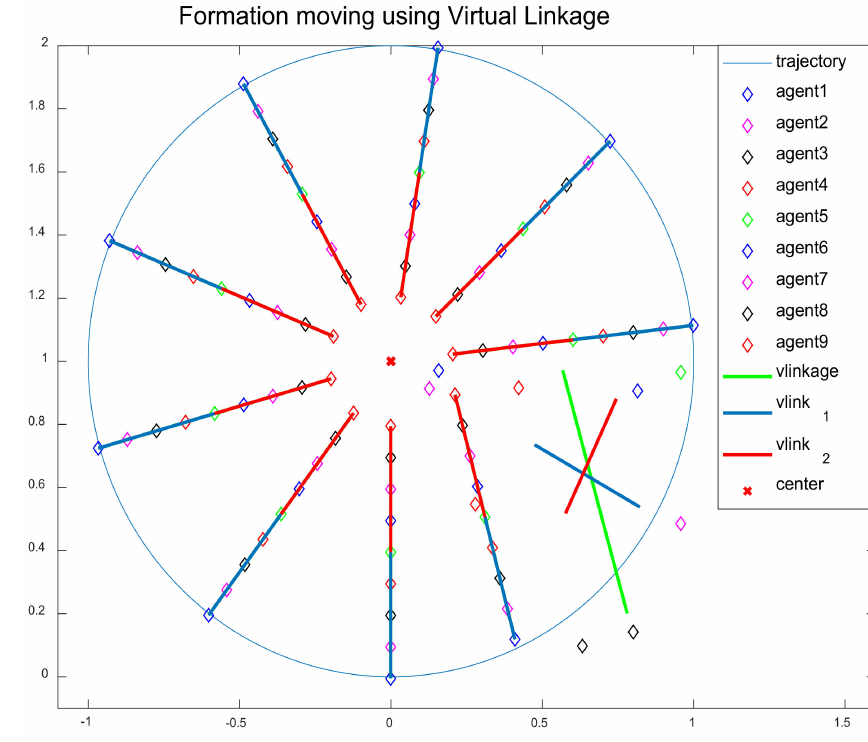
Figure 12. Snapshots of the formation moving.